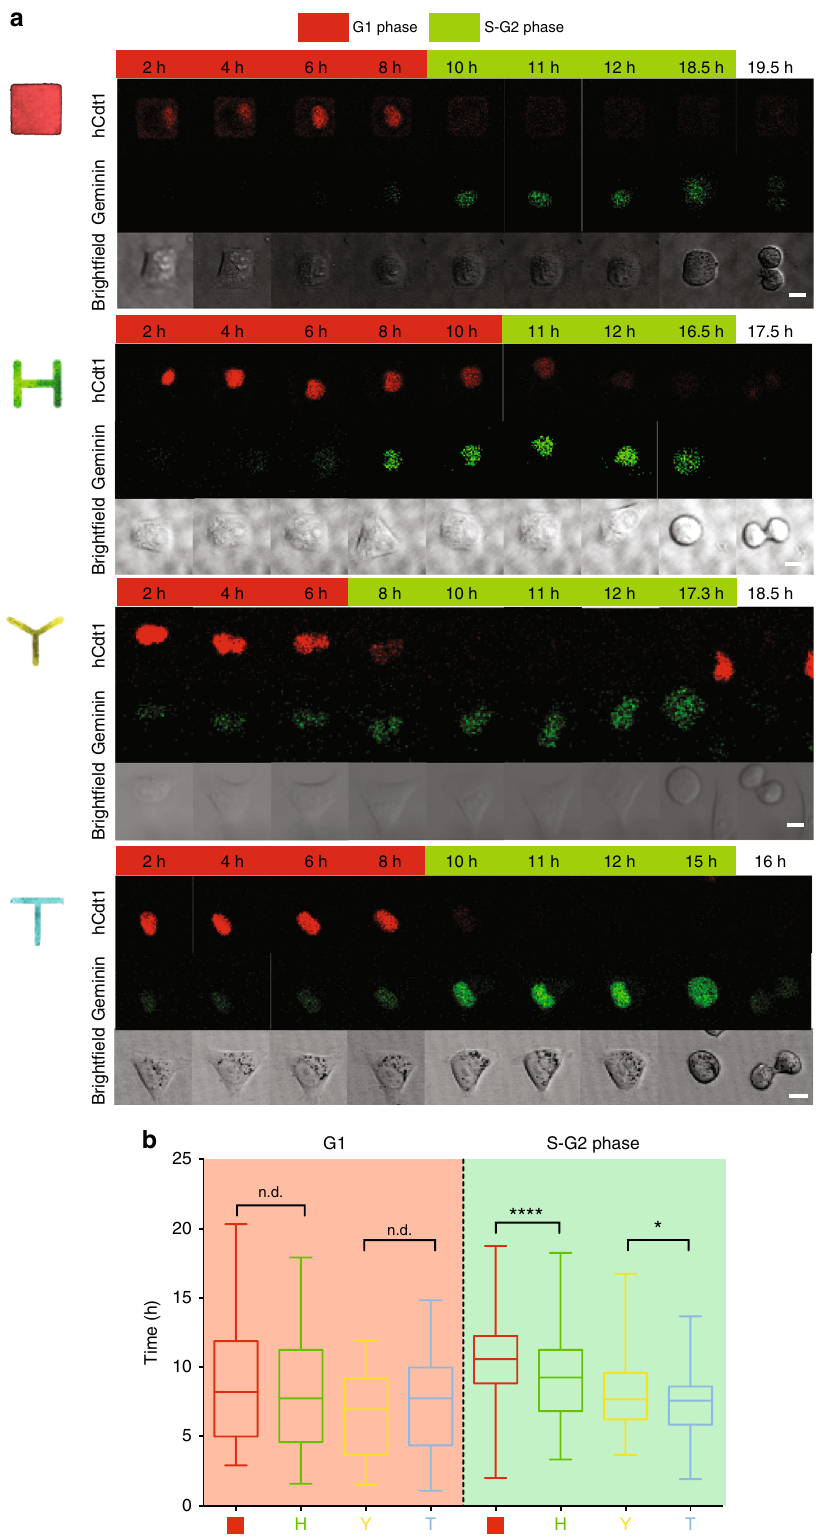
Fig. 5 Mechanical polarization reduces S-G2 phase duration. a Representative hCdt1 (G1-to-S phase reporter in red) and Gemin (S-to-G2 phase marker in green) signal time-lapse for FUCCI HeLa cells plated on respective micropatterns (scale bar = 10 μ m). Time is in hours. Images correspond to Supplementary Movies 11 – 14. b G1/S and S-G2 (to NEB: nuclear envelope breakdown) time plot for all the H2B-GFP cells imaged overnight after thymidine release. Whiskers represent minimum and maximum values. Box extends from the 25th to 75th percentiles. Line corresponds to median (Square n = 90 cells, Tripod n = 68 cells, H n = 71, T n = 53 cells). Time is in hours. p -values were obtained with unpaired two-tailed t -test; ** p < 0.01, **** p <